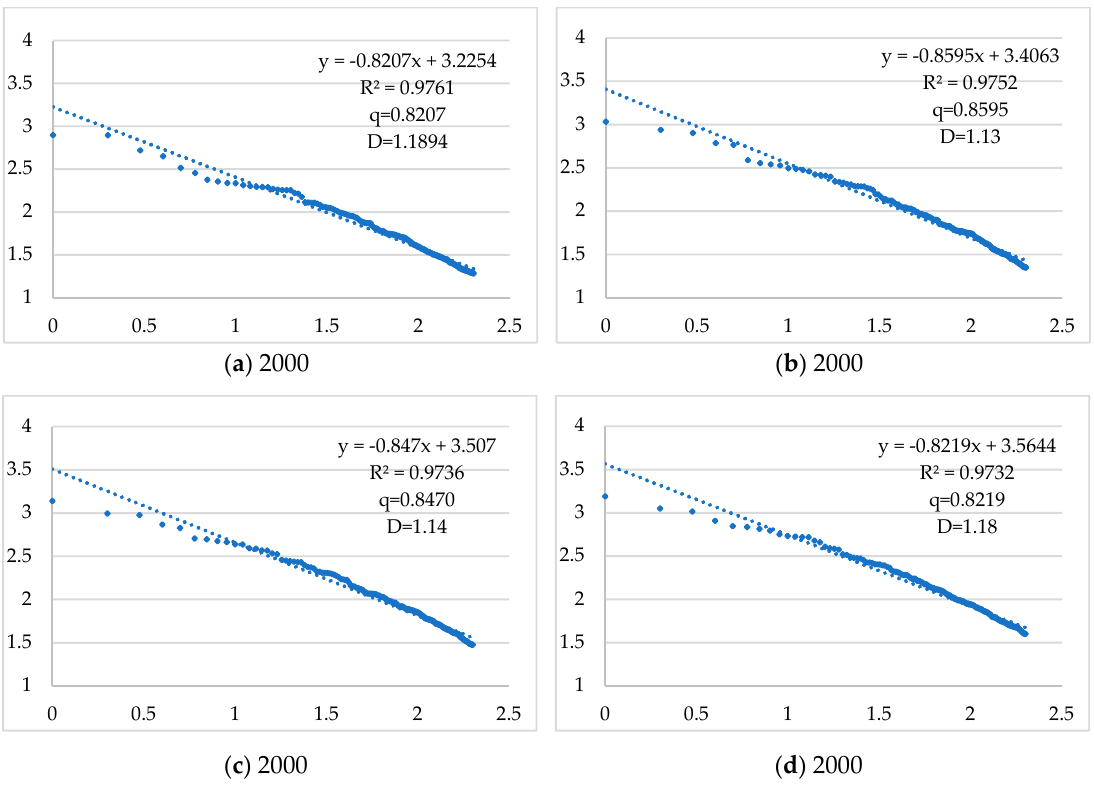
Figure 8. Change of Zipf Index and structural capacity in China’s cities system from 2000–2015. China implemented the urban development policy of “strictly controlling the scale of large cities and highlighting the development of small towns,” combined with its urban development policy from 1996 to 2000, and implemented the diversified urban development policy of “coordinated development of large, medium, and small cities and towns” in 2000–2005 (Table 2). Table 2. The policies and characteristics of urban development during different periods. Period